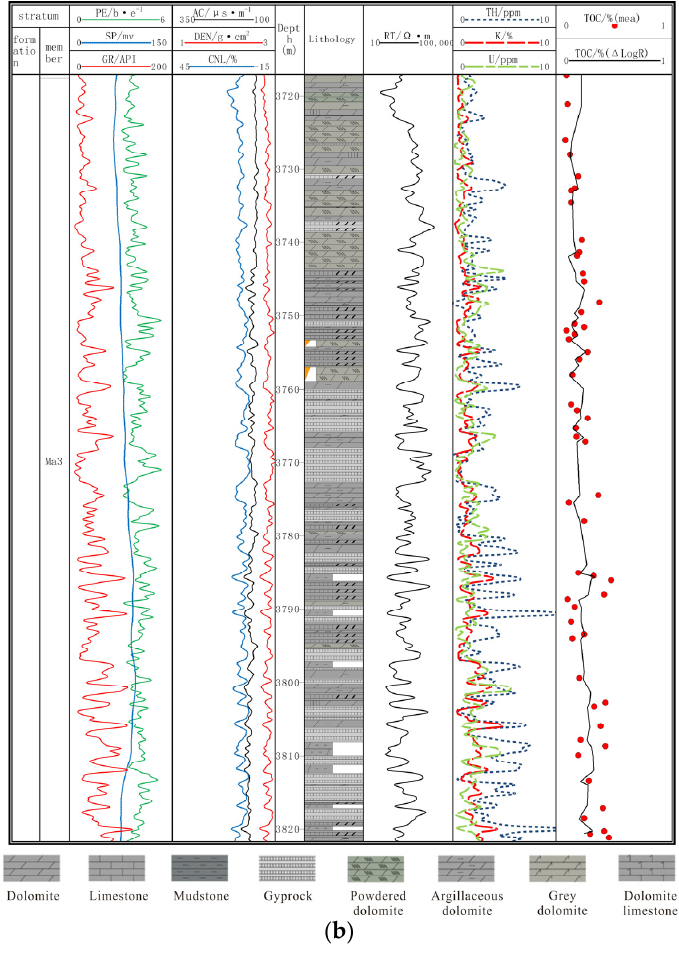
Figure 7. TOC prediction results by Δ log R method in LT1 well: ( a ) Ma 5 6–10 and ( b ) Ma 3.